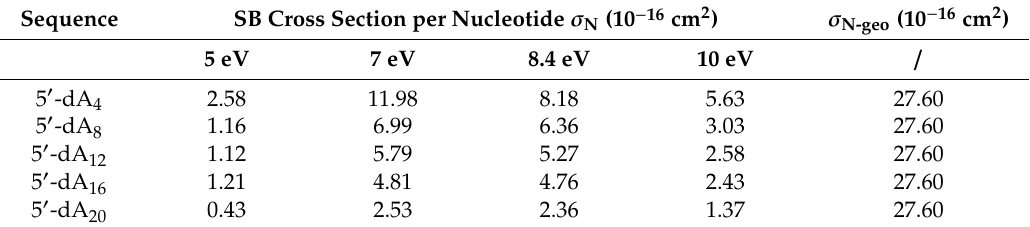
Figure 4. Absolute cross section for SBs (black) and the estimated geometrical cross section (blue) for all DNA sequences 5 ′ -d(A n ) n = 4, 8, 12, 16, 20 irradiated at 5.0, 7.0, 8.4, and 10 eV plotted against the number of nucleotides. Solid and dotted lines connect the data points to guide the eye. Table 2. Overview of absolute SB cross sections per nucleotide for experimental data σ N and geometrical cross section σ N-geo calculated from the determined values in Table 1.